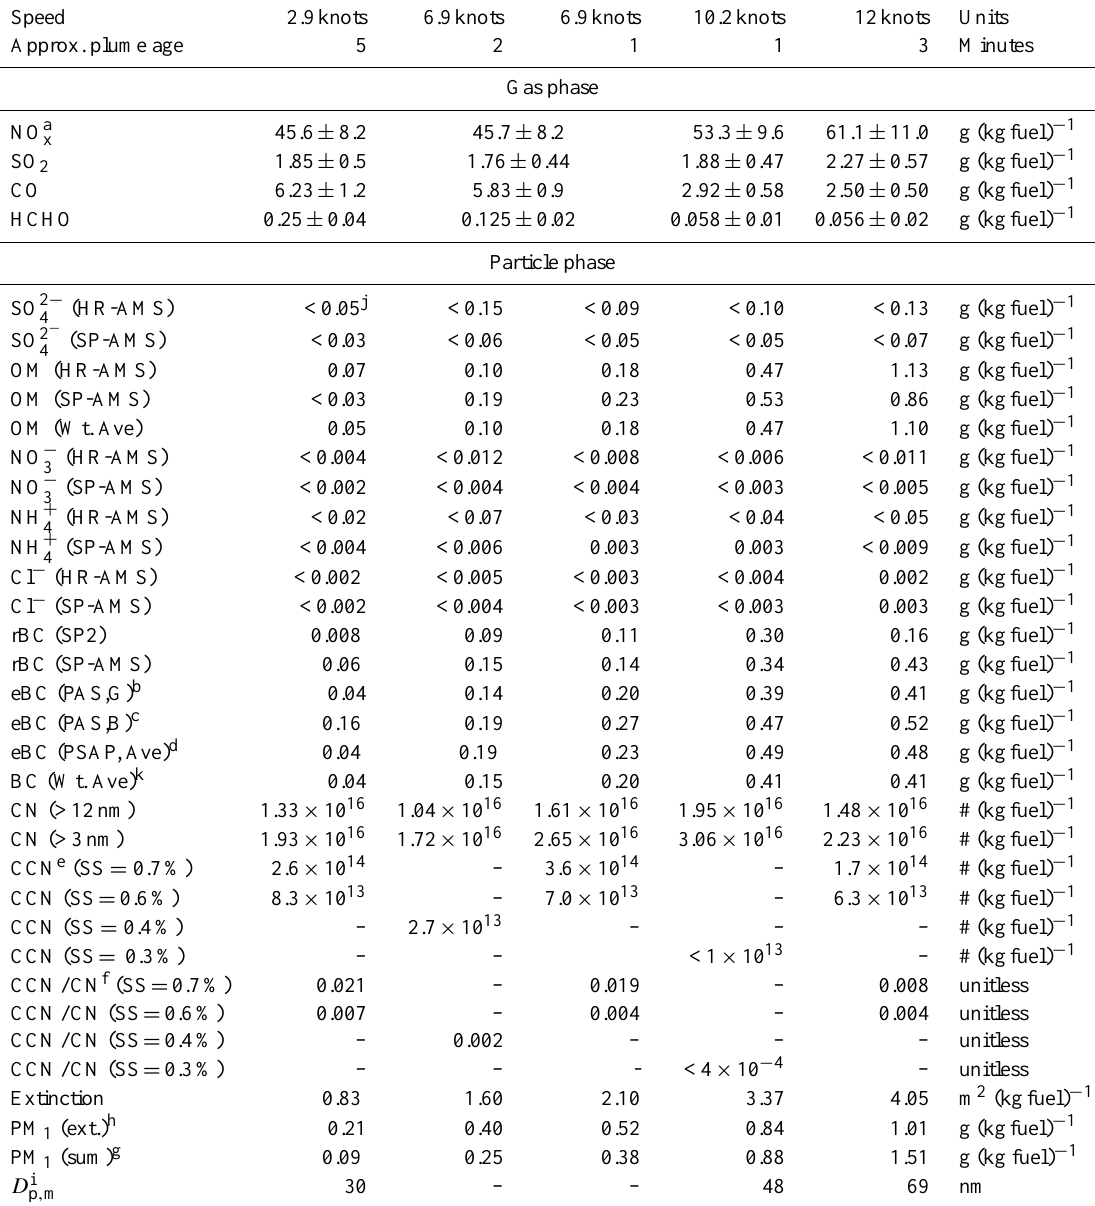
Table 1. Measured emissions factors for the NOAA ship Miller Freeman as a function of vessel